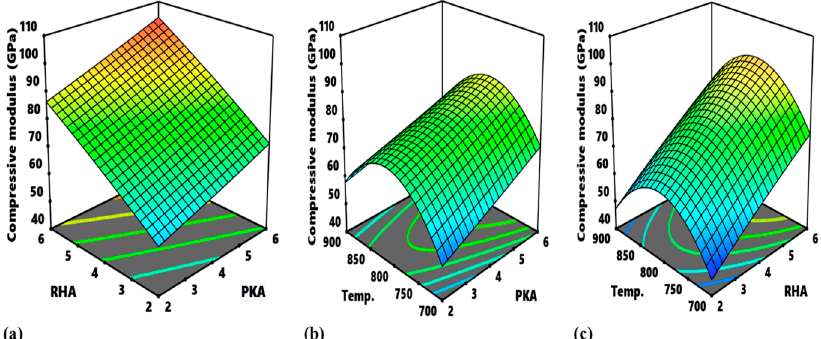
Figure 12. Surface plots representing the relationship of the variables affect compressive modulus as revealed by interactions ( a ) PKA vs. RHA, ( b ) PKA vs. stirring temperature, and ( c ) RHA vs. stirring temperature.